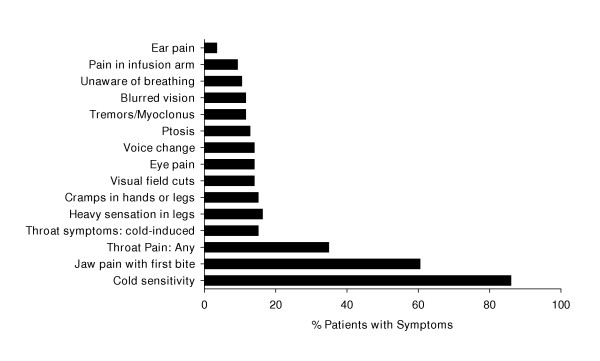
Percentage of subjects experiencing specific types of symptoms due to acute peripheral sensory and motor nerve hyperexcitability (n = 86 subjects).